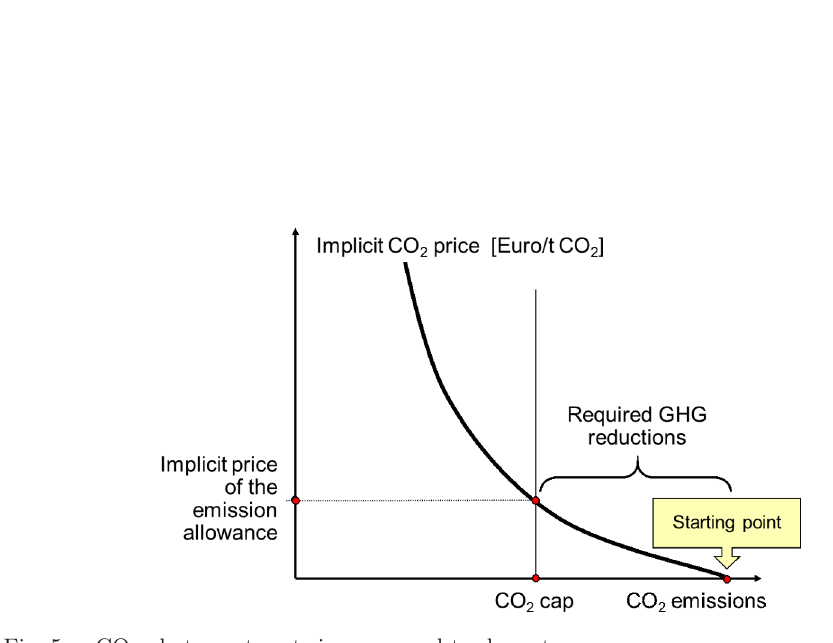
Fig. 5. – CO 2 abatement costs in a cap-and-trade